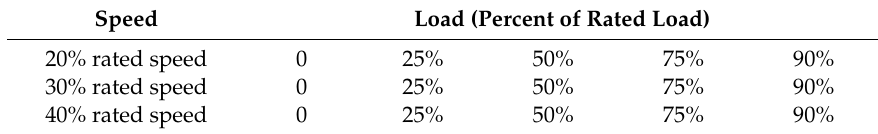
Figure 7. The pitting fault on sun gear. Table 4. Operating conditions of the planetary gearbox system.